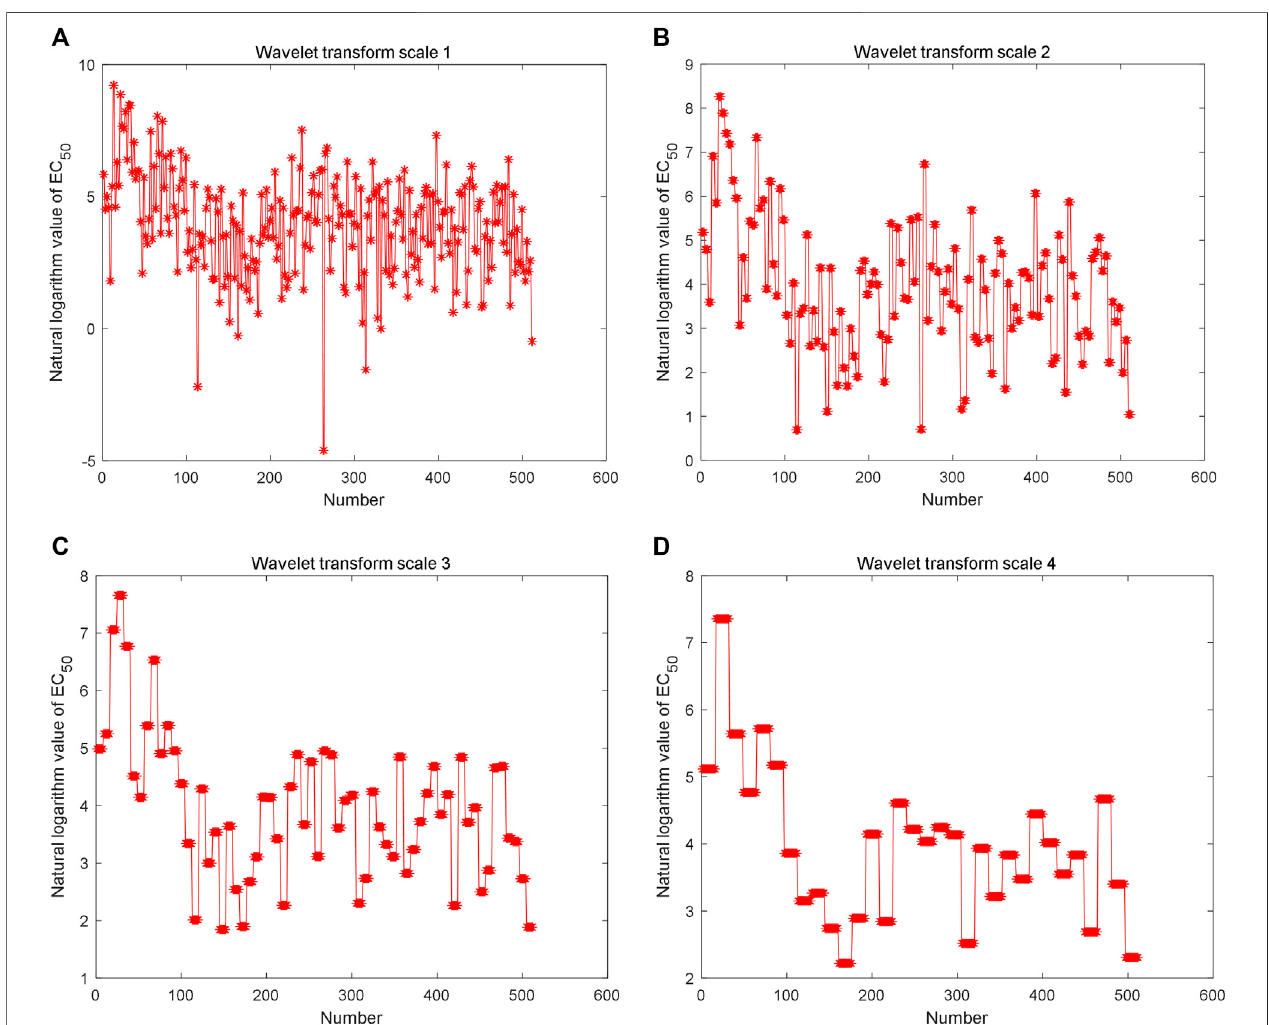
FIGURE 5 | Multi-scale wavelet decomposition of constructed time series: low frequency data of (A) level 1 wavelet transform, (B) level 2 wavelet transform, (C) level 3 wavelet transform, and (D) level 4 wavelet transform.